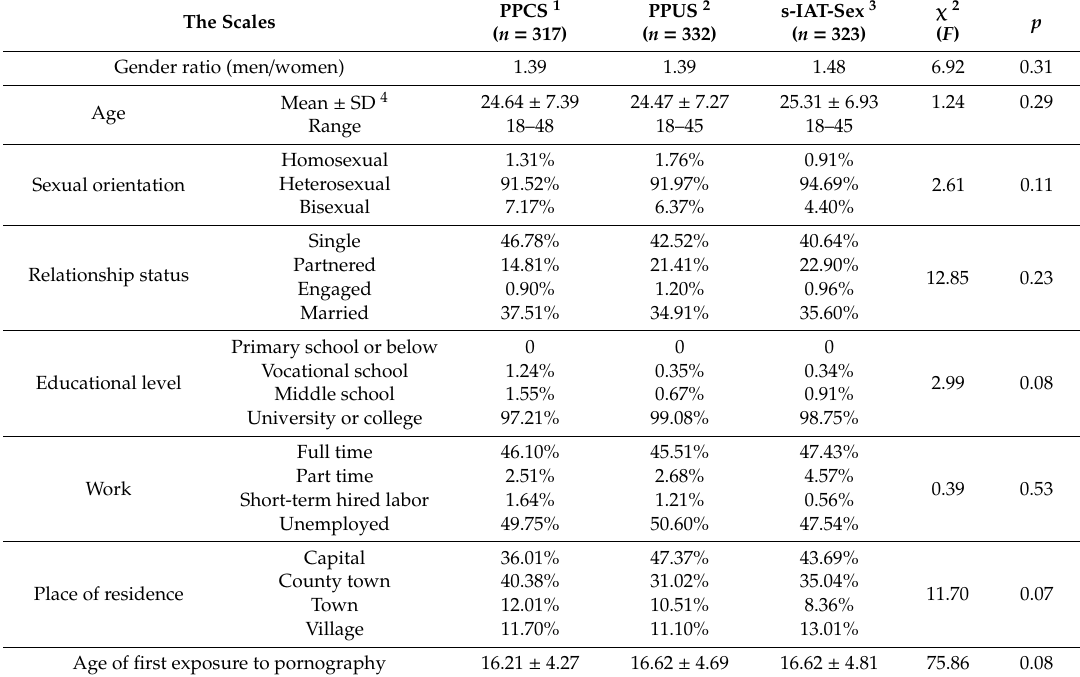
Table 1. Group comparisons of the demographic characteristics of the three study